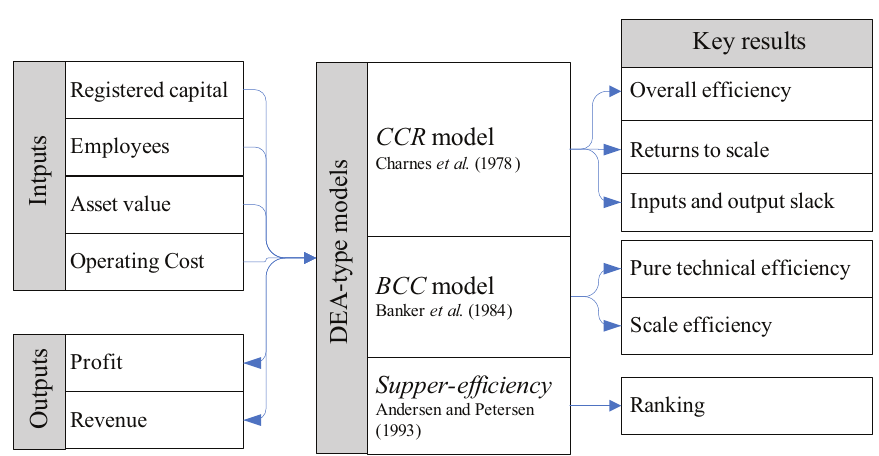
figure 2. an overview of the research